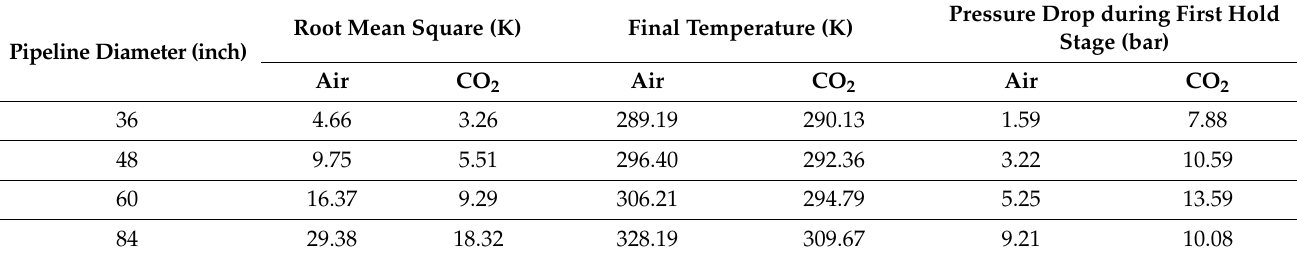
Table 5. Root mean square and final temperature of the charging stage along with the pressure drop experienced during the first hold stage for both air and CO 2